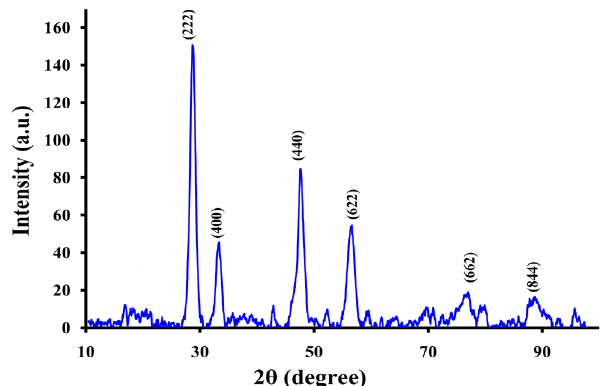
Fig. 5. XRD patterns of Gd (sample no. 3).